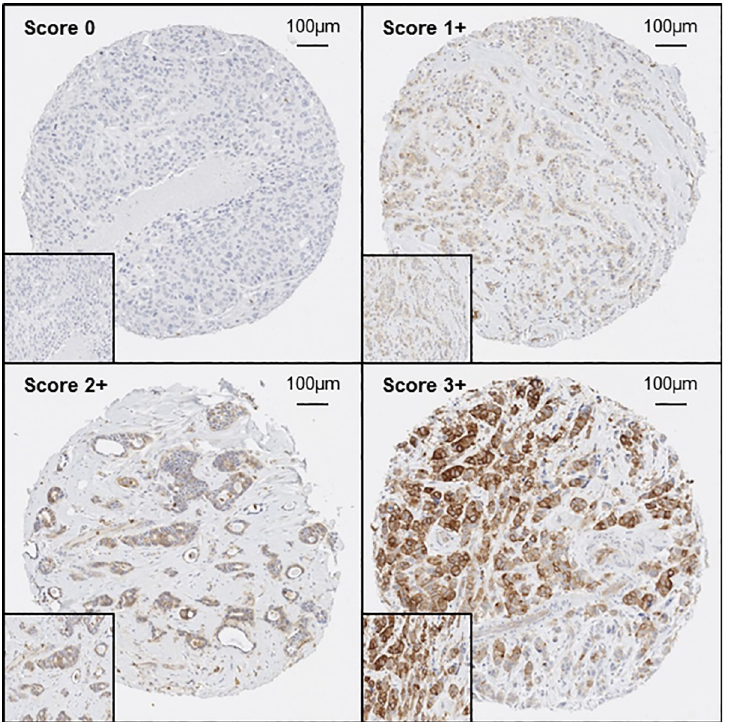
Fig 2. pHER2Y877 staining. The staining obtained is similar to HER2 with the four scores from the 2013 ASCO/CAP scoring guidelines. 0 = No staining is observed, or membrane staining is observed in less than 10% of tumor cells. 1+ = A faint/barely perceptible incomplete membrane staining is detected in more than 10% of tumor cells. 2+ = A weak to moderate complete membrane staining is observed in more than 10% of tumor cells. 3+ = A strong complete membrane staining is observed in more than 10% of tumor cells. The scoring defines a HER2 status; HER2 status is considered negative for scores of 0 and 1+, equivocal for a score of 2+ and positive for a score of 3+.